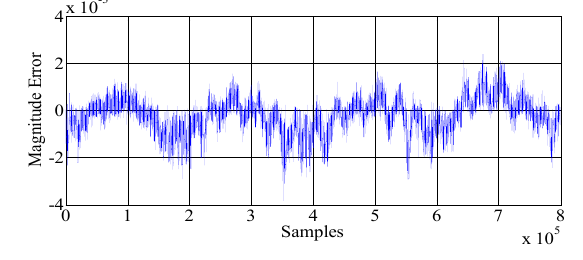
Fig. 7 Magnitude error after calibration